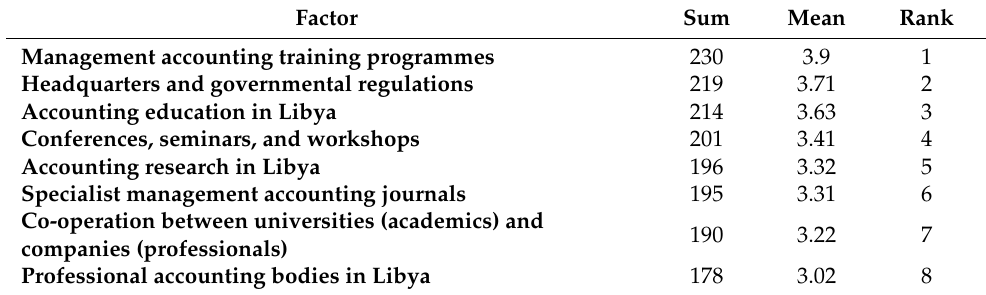
Table 13. Institutional factors facilitating the adoption of MAIs in the non-manufacturing